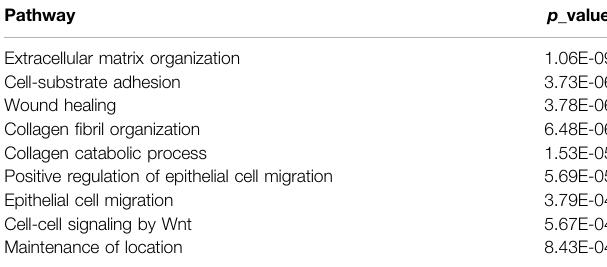
TABLE 1 | Results of stemness-related key gene enrichment analysis.